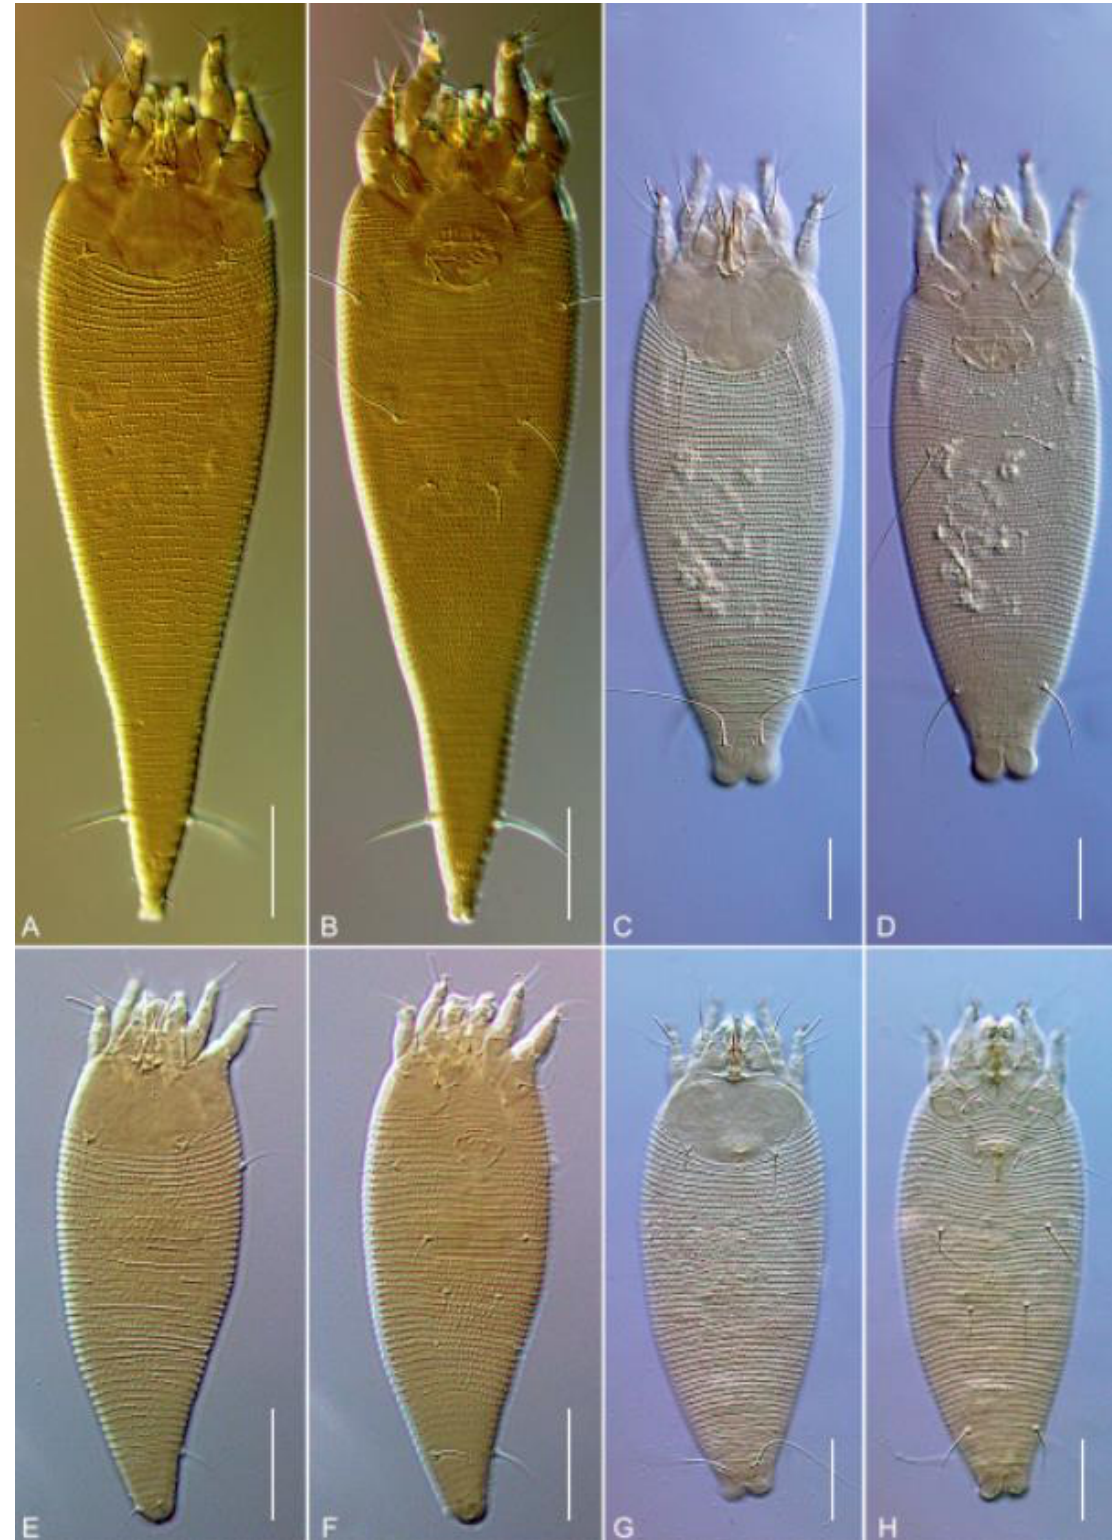
Figure 5. DIC LM images of females ( A – D ) and males ( E – H ) of morphotype A ( A , B , E , F ) and morphotype B ( C , D , G , H ) of Aberoptus schotiae n. sp. ( A , C , E , G )—dorsal view; ( B , D , F , H )—ventral view. Scale bars: ( A , B , E , F ) = 40 µm; ( C , D , G , H ) = 30 µm.